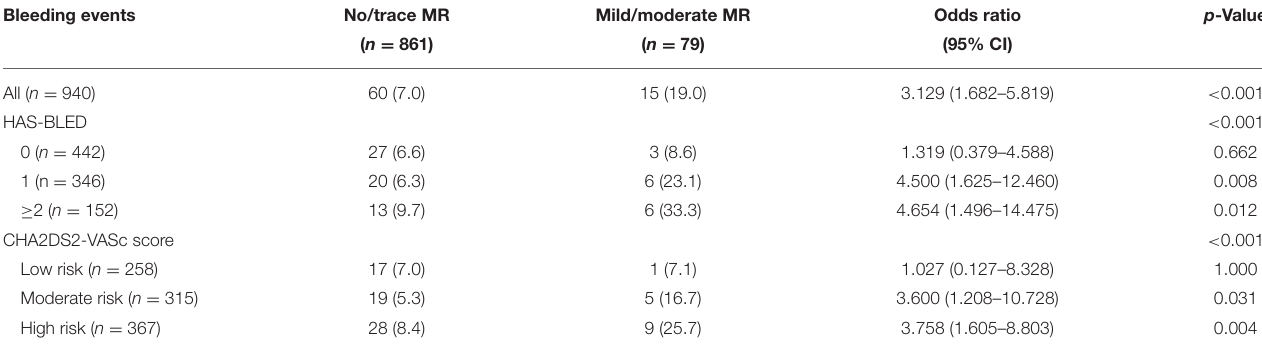
TABLE 5 | Odds ratio of mitral regurgitation (no/trace MR vs. mild/moderate MR) by different subgroups based on the CHA2DS2-VASc score and HAS-BLED score. Bleeding